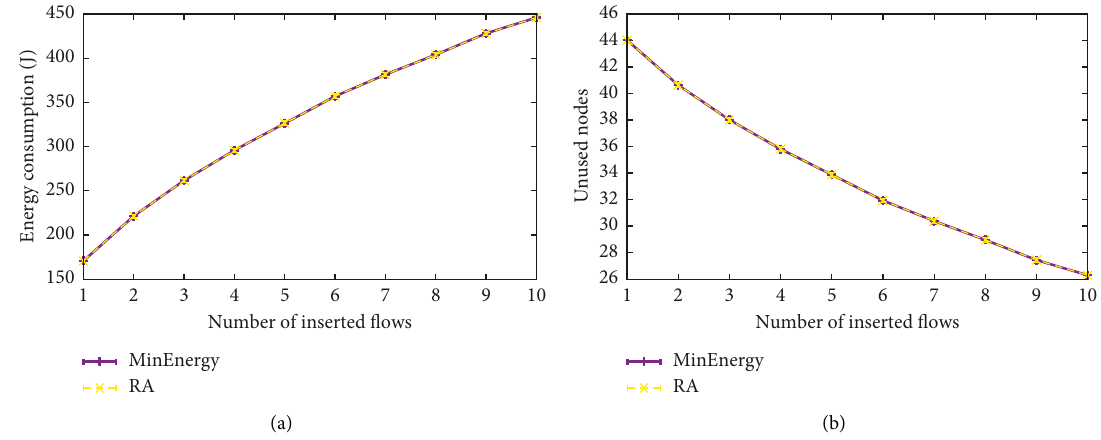
Figure 6: Equivalence between energy consumption and number of nodes used. (a) Overall energy consumption. (b) Number of unused nodes.